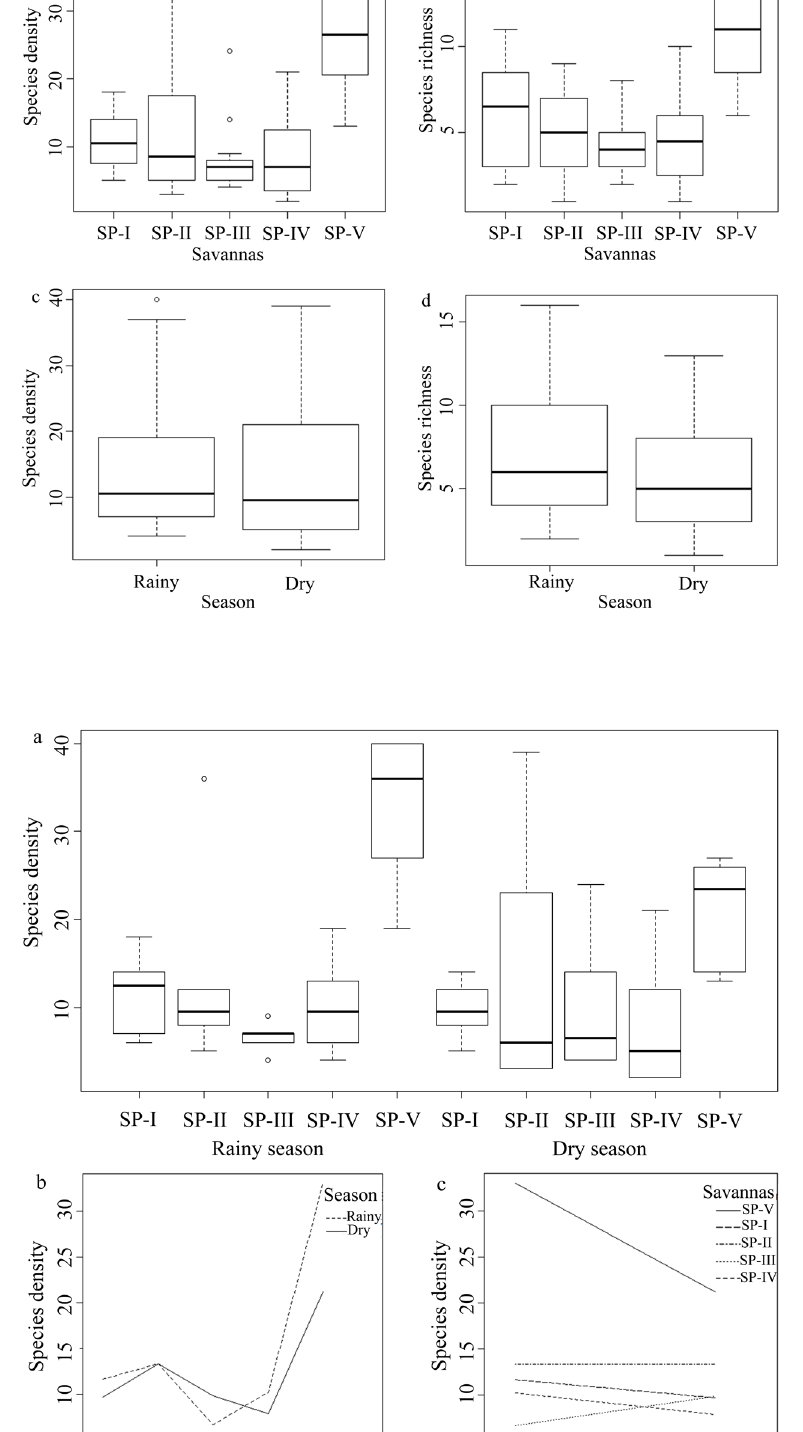
Figure 3. Mean density and richness of species per plot in the studied areas and seasons in Marajó island, Pará. (a) Mean density in the five Park Savanna areas; (b) Mean richness in the five Park Savanna areas; (c) Mean density in the two seasons; (d) Mean richness in the two